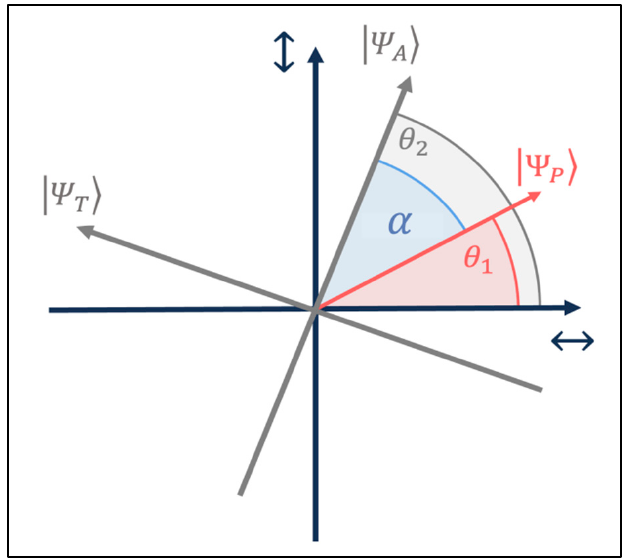
Figure 1. Visualization of polarization states of photons at a polarizer. To determine transmission and absorption probabilities, the polarization state | Ψ P (cid:105) is projected onto | Ψ T (cid:105) and | Ψ A (cid:105) , respectively. See text for details.